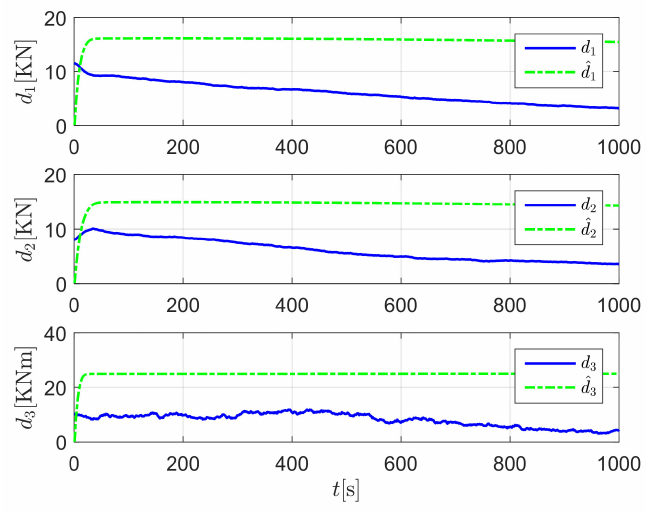
Figure 13. The estimation curves of τ f for external